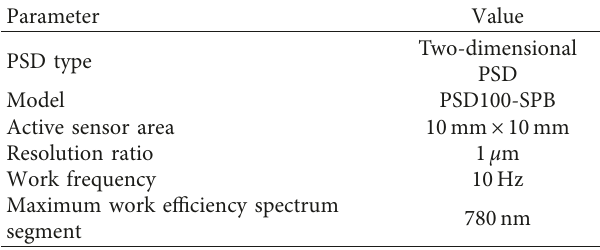
Table 4: Experimental PSD parameters.